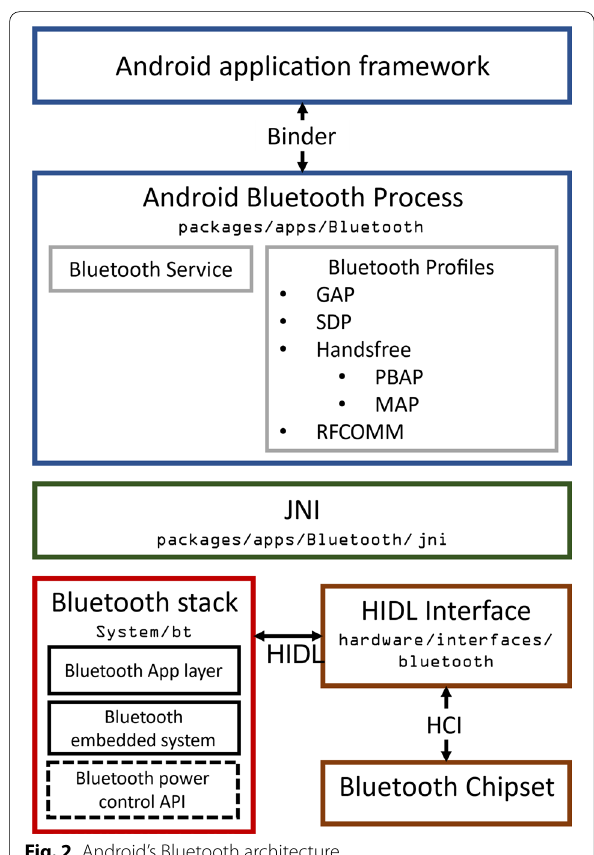
Fig. 2 Android’s Bluetooth